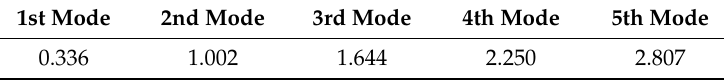
Table 1. Natural frequencies of the benchmark structural model (Hz).